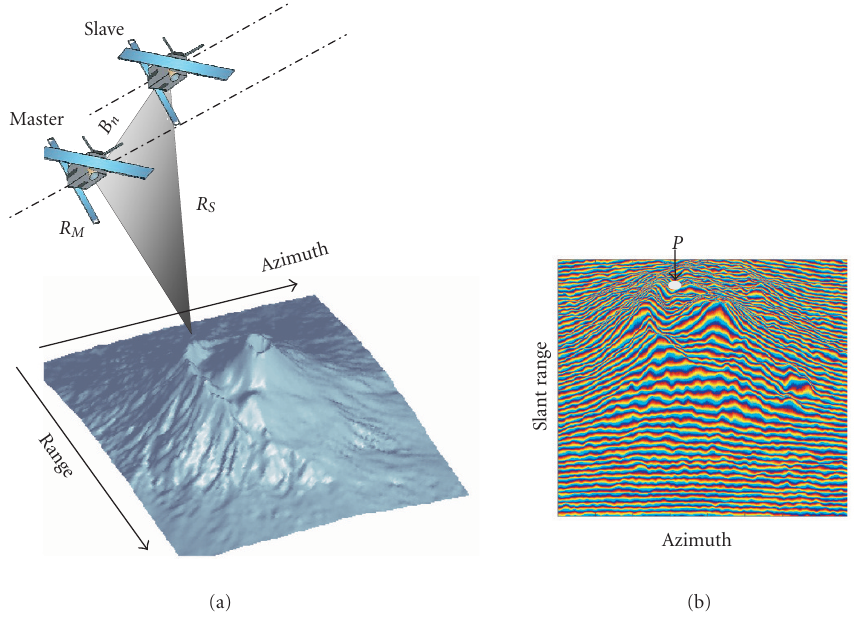
Figure 1: Interferometric SAR geometry: a master and a slave sensor, at the same azimuth position, are shown. The travel path distance, converted into phases, is shown in